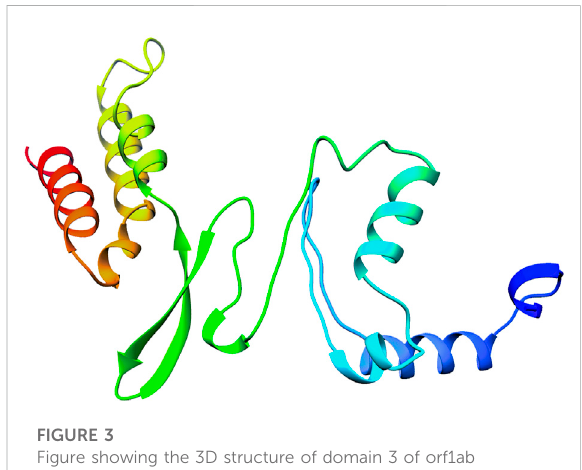
FIGURE 3 Figure showing the 3D structure of domain 3 of orf1ab predicted by the trRosetta online web server.